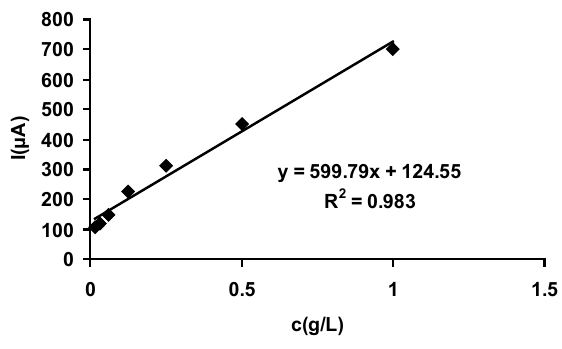
Figure 7: Detail on the calibration graph at sulfite concentrations below 1 g L -1 , obtained with the Pt ring electrode Mettler-Toledo